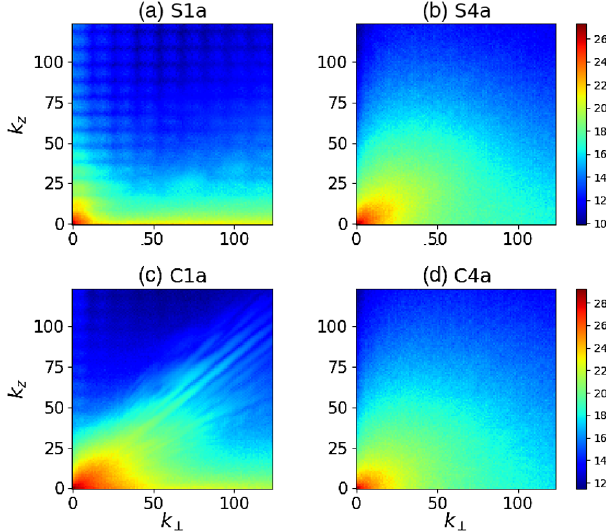
FIG. 11. The k z - k ⊥ spectrum of the velocity field of fast modes for the four simulations S1a, S4a, C1a, and C4a.